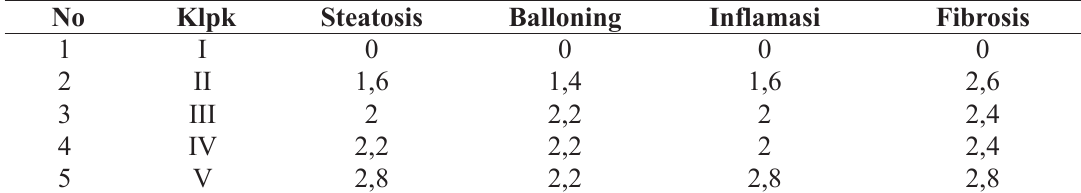
Tabel 3. Rerata NAS score dan